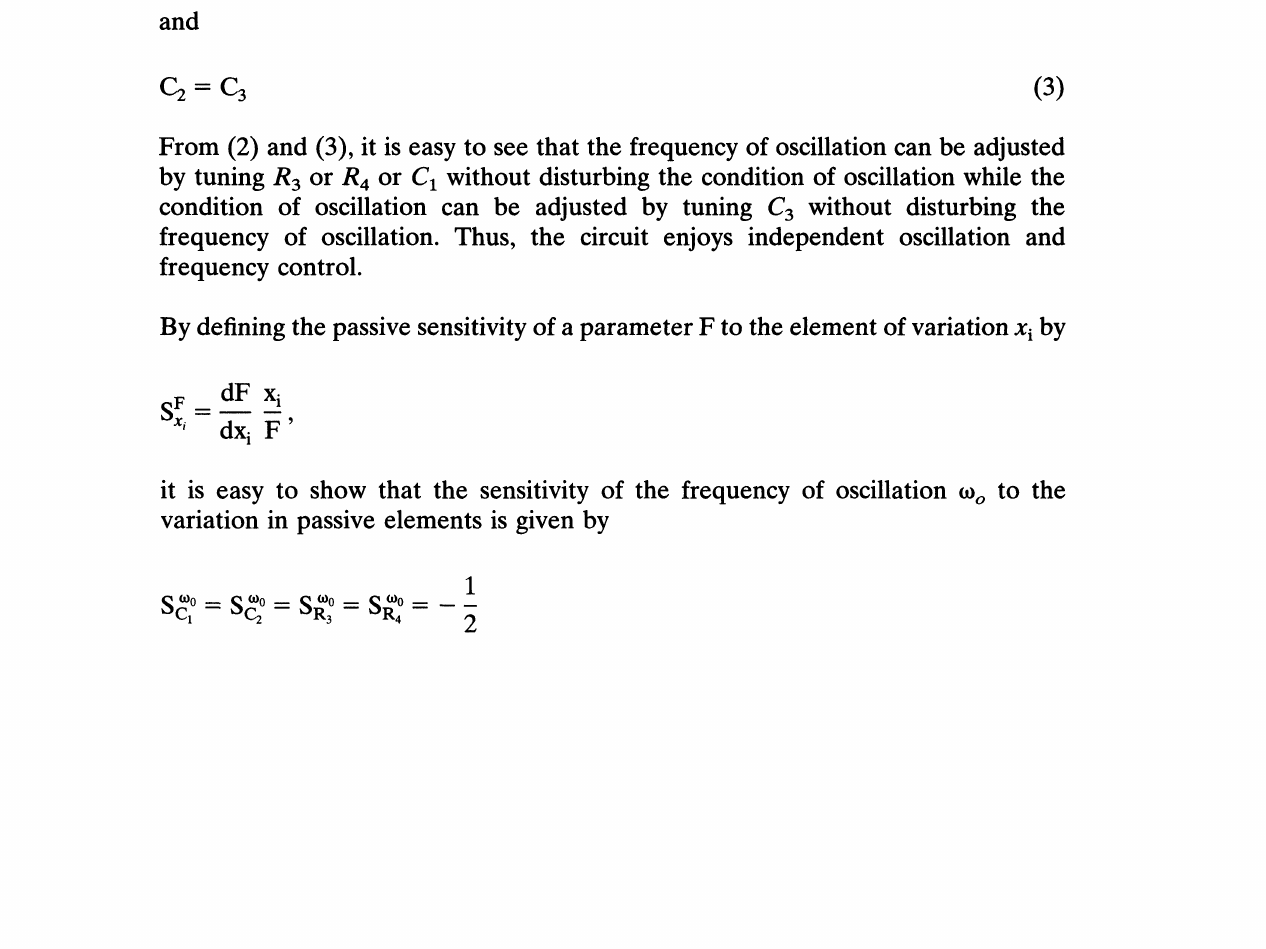
FIGURE 1 Proposed current-conveyor sinusoidal oscillator